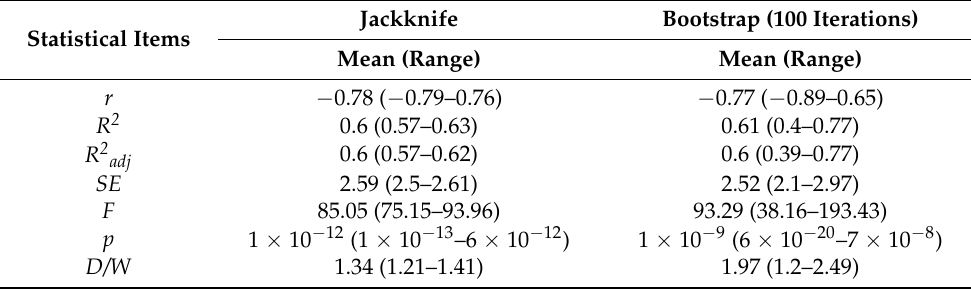
Table 4. Verification results from Bootstrap and Jackknife